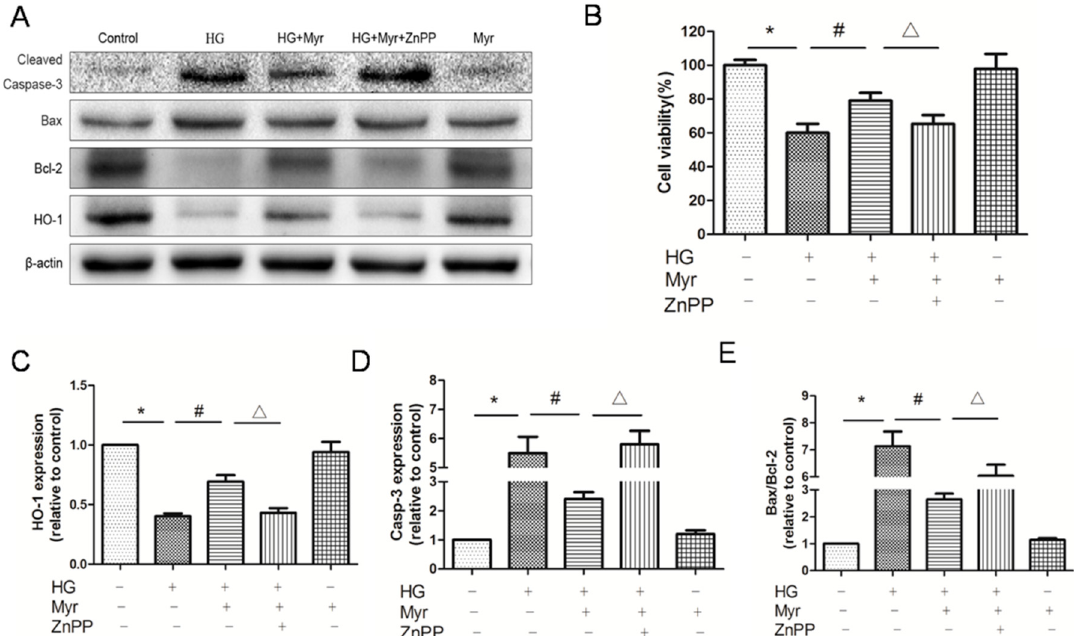
Figure 6. The anti-apoptotic effects of myricitrin were attenuated by HO-1 inhibitor. The expressions of target protein were evaluated by Western blot assay. ( A ) Representative immunoblots of the protein expression of HO-1, cleaved caspase-3, Bax and Bcl-2; ( B ) Cell viability of H9c2 cells with 48 h pretreatment of ZnPP (10 µ M) was evaluated by MTT assay. n = 10 wells per group. Quantitative analysis of HO-1 ( C ) and cleaved caspase-3 expression levels ( D ) and the statistical analysis of the Bax/Bcl-2 expression level relative to the control group ( E ). Values are represented as the mean ± SD ( n = 3). * p < 0.01 vs. control; # p < 0.01 vs. HG; ∆ p < 0.05 vs. HG + Myr. + represents treated; − represents untreated.